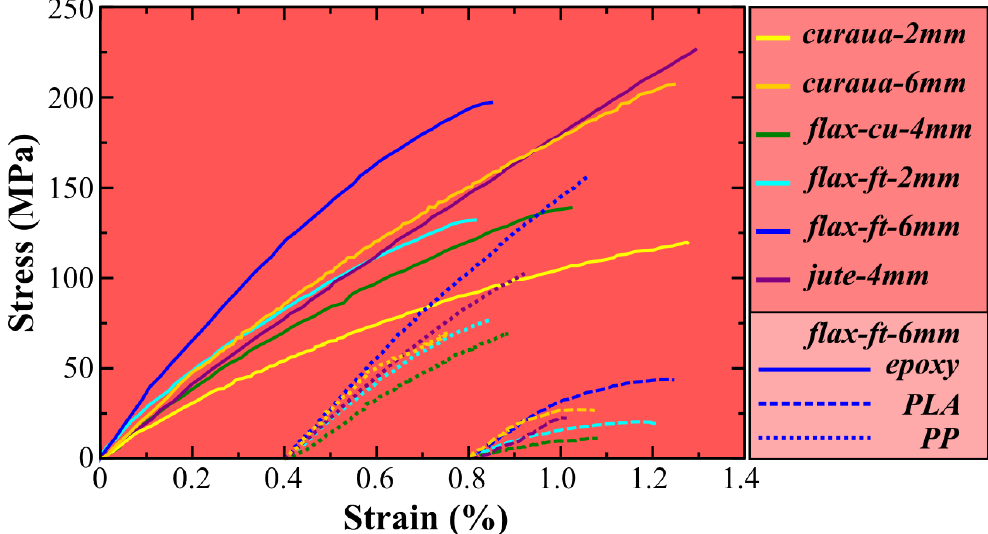
Figure 7. Representative stress–strain curves for the tensile tested aligned discontinuous natural fibre composites specimens and the colour/line code. For PLA and PP curves, 0.8 and 0.4 strain reference points are the starting points,